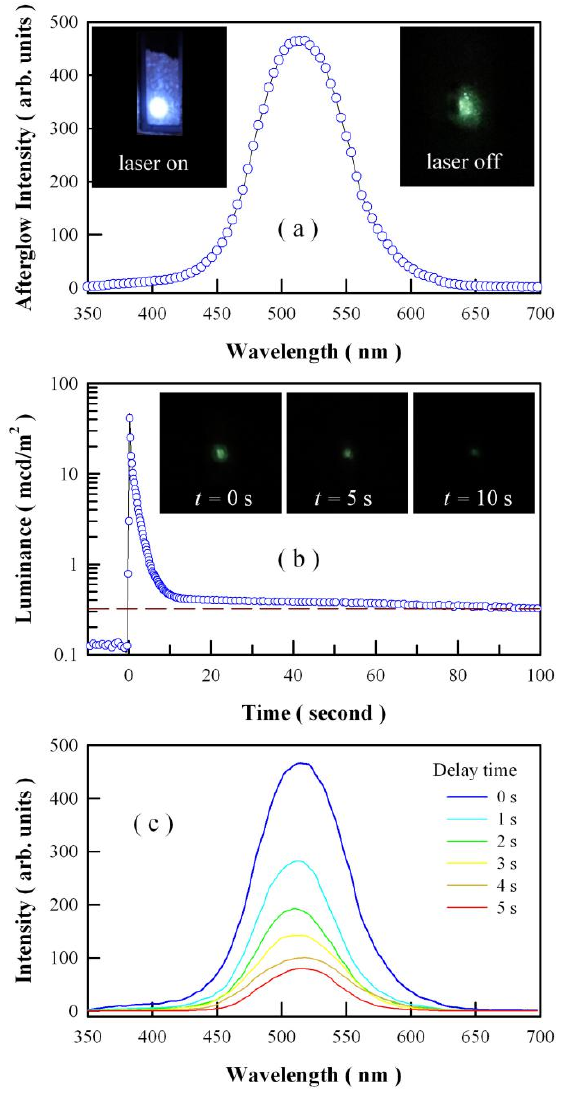
Figure 5. ( a ) Afterglow spectrum of undoped SrAl 2 O 4 . Insets in the top panel: photographs of the undoped SrAl 2 O 4 when the irradiation of an ultraviolet laser (325 nm, 13 mW) is turned on (left) and off (right). ( b ): Afterglow decay profile of undoped SrAl 2 O 4 , which was taken after exposure to ultraviolet laser of 325 nm for 5 min. Insets in the middle panel: afterglow photographs of the undoped SrAl 2 O 4 taken at 0, 5, and 10 s after the extinction of the irradiation of the ultraviolet laser. ( c ) Afterglow spectra of undoped SrAl 2 O 4 measured at different delay times after the extinction of the ultraviolet illumination of the He-Cd laser.